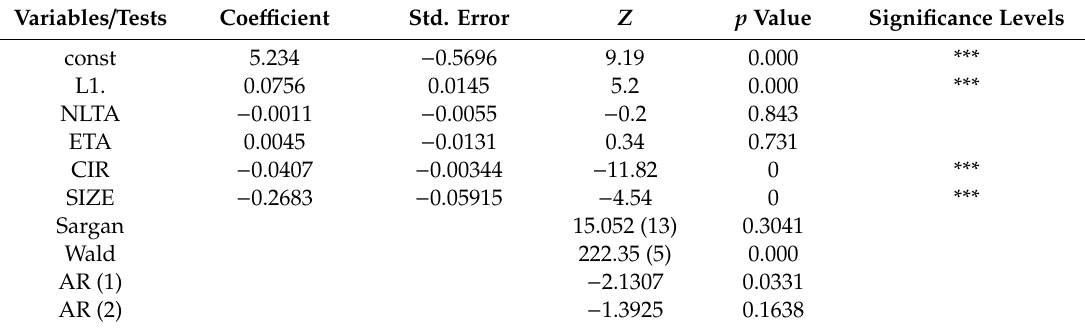
Table 3. Estimation results of the model (1).